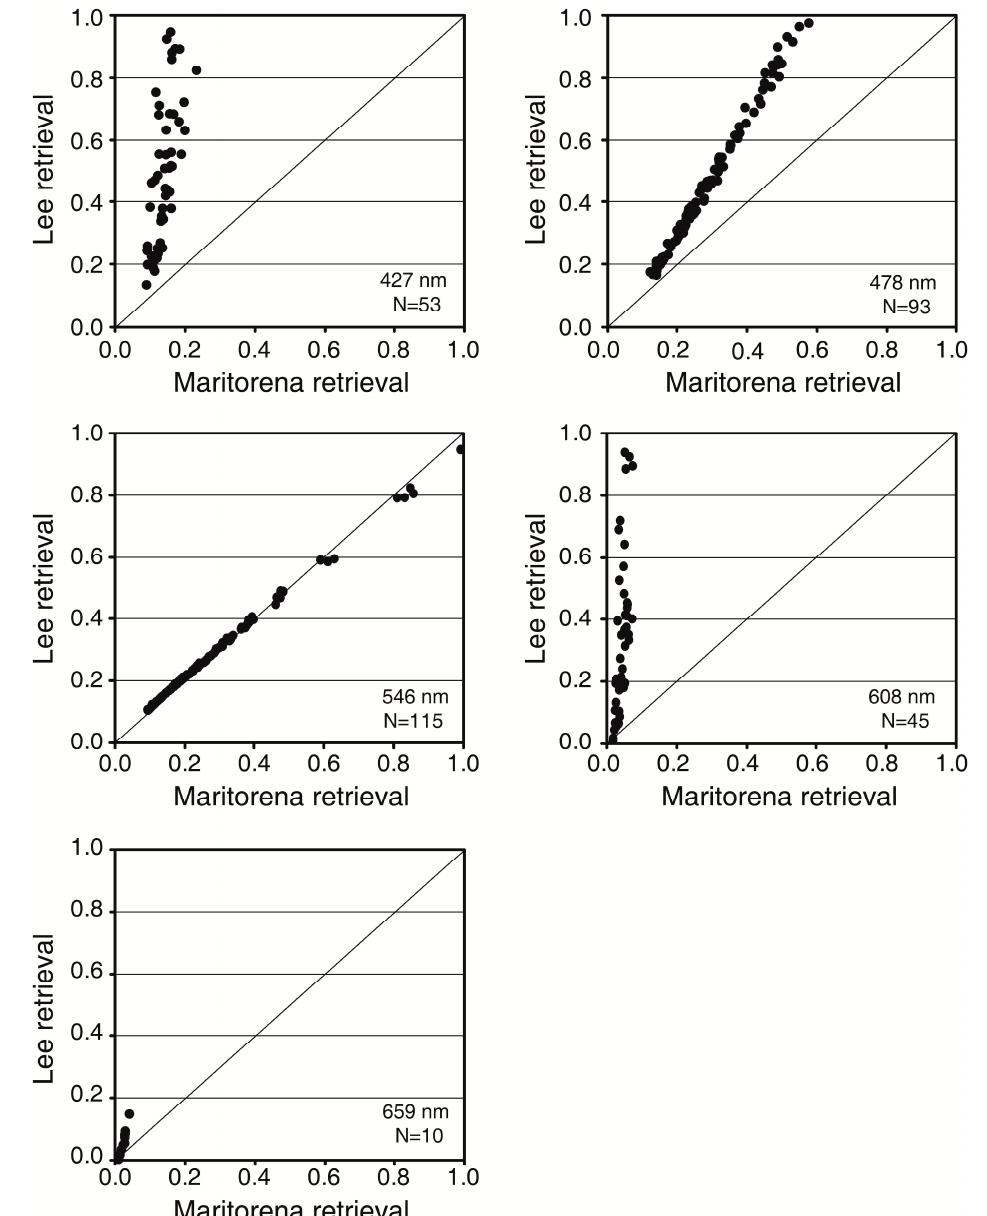
Figure 13. Bottom reflectance retrieved using L99 versus M94 retrieval from WV02 image. Each plot corresponds to a different wavelength (427, 478, 546, 608 and 659 nm). Straight lines correspond to proportion